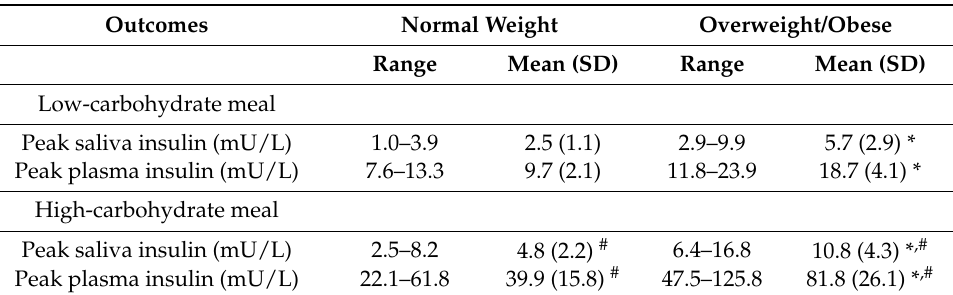
Figure 4. Relationships between plasma and saliva insulin concentrations. ( A ) Fasting plasma and saliva insulin; ( B ) Two-hour plasma and saliva insulin total area under the curve (AUC) following the high-carbohydrate (HC) meal; ( C ) Two-hour plasma and saliva AUC following the low-carbohyrate (LC) meal. Table 2. Insulin peak values following the ingestion of mixed meal breakfasts in normal weight and overweight/obese participants.